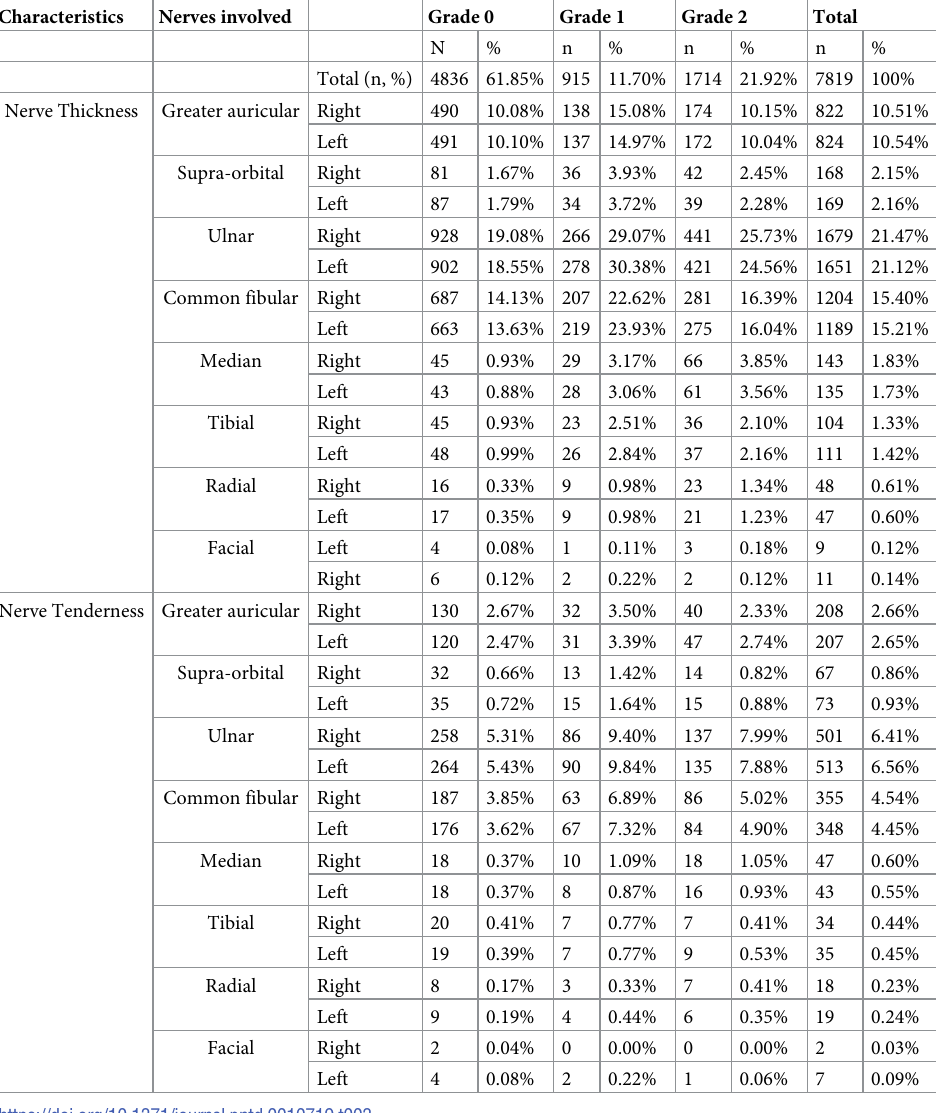
Table 3. The Characteristics of Nerve Involvement Among Leprosy Patients in Yunnan, China, 1990–2020.